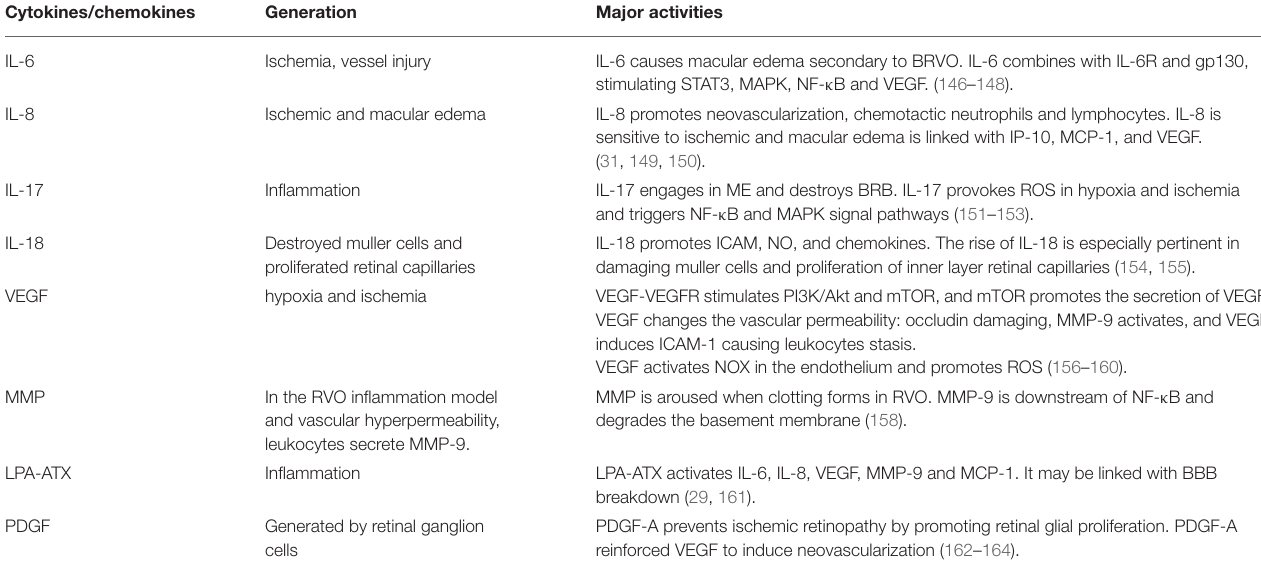
TABLE 2 | Cytokines and chemokines in